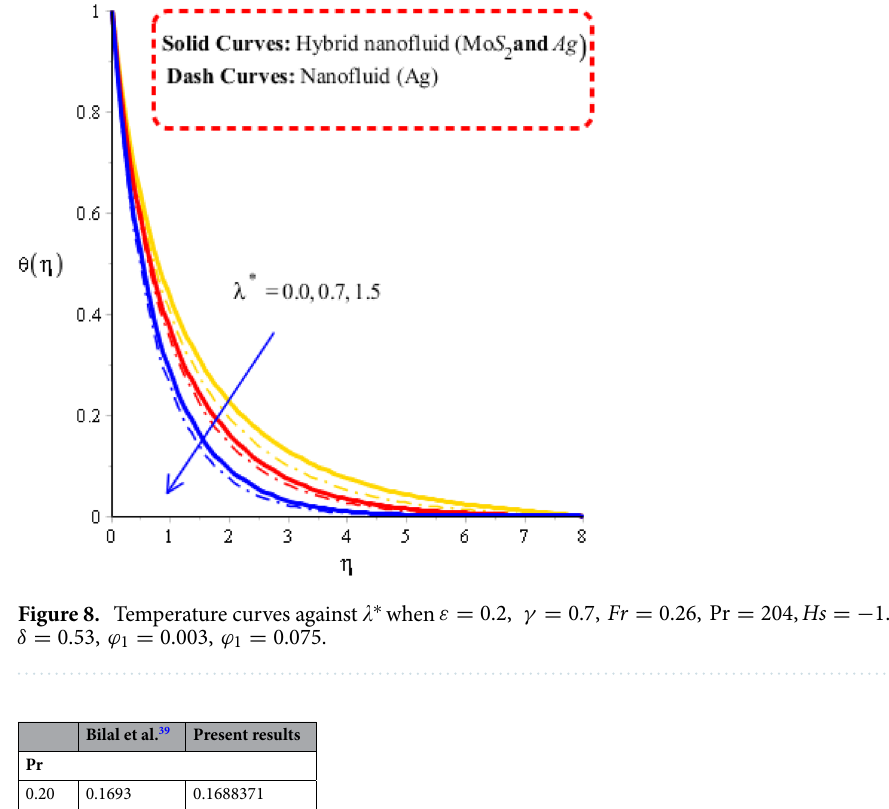
Bilal et al. 39 Present